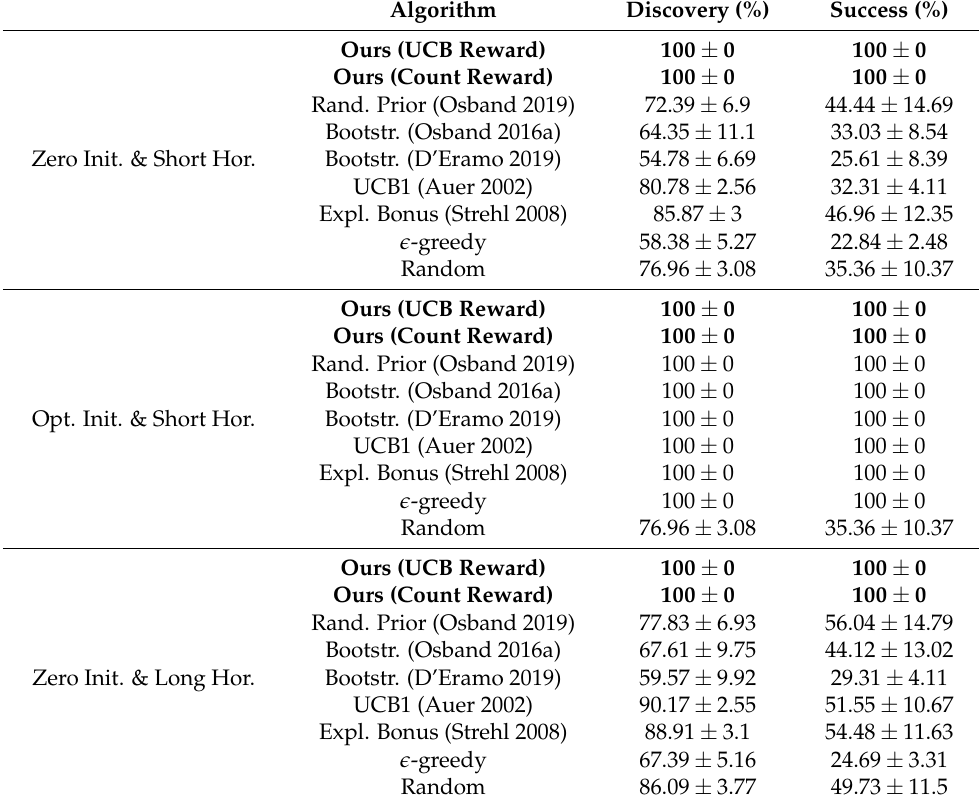
Table A6. Gridworld (prison) results